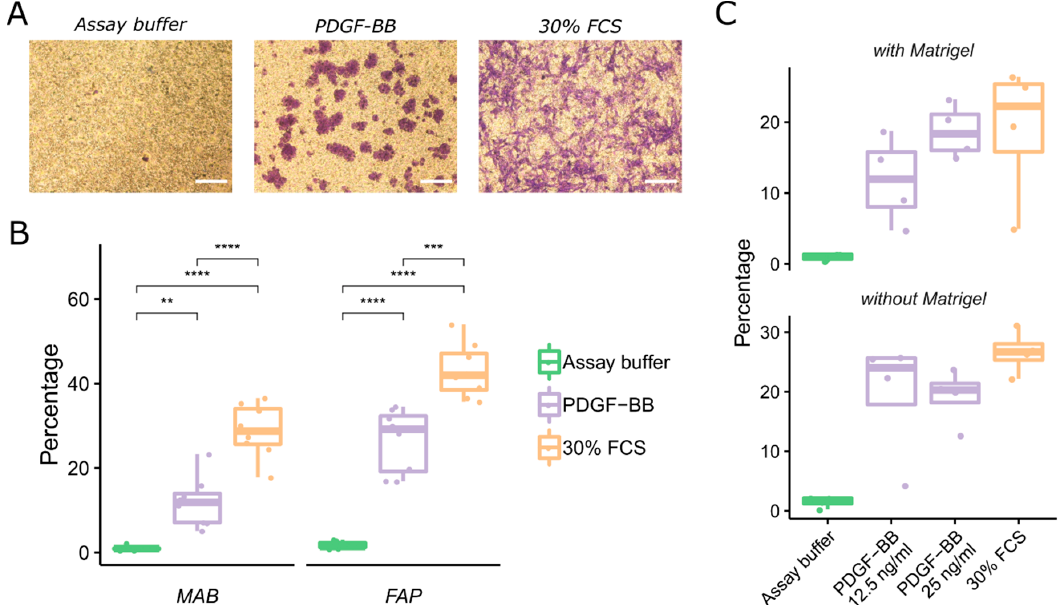
Figure 5. Interstitial stem cells migrate towards PDGF-BB. ( A ) Crystal violet staining of mesoangioblasts after transwell migration to the assay buffer (negative control), PDGF-BB and 30% FCS (positive control). Representative images shown. ( B ) Percentage of migrated cells shown in ( A ); n = 8. ( C ) Percentage of migrated fibro/adipogenic progenitors to different concentrations of PDGF-BB over Matrigel or no Matrigel-coated transwells; n = 4. * p ≤ 0.05, ** p ≤ 0.01, *** p ≤ 0.005, **** p ≤ 0.001, t -test. Scale bar, 50 µm.